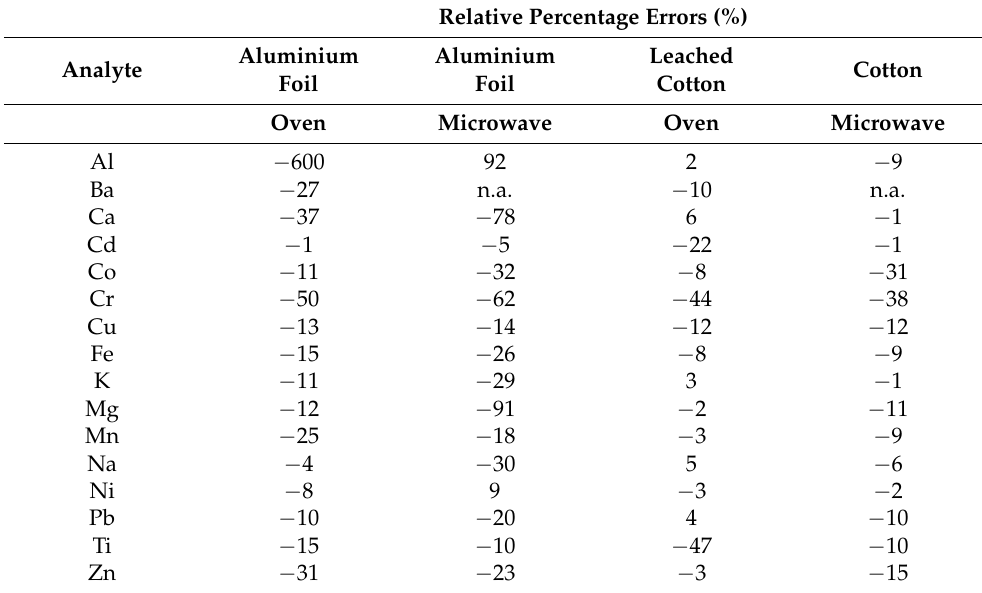
Table 3. Results of preliminary checks—relative percentage errors obtained for CRM NIST 1648 (“Urban particulate